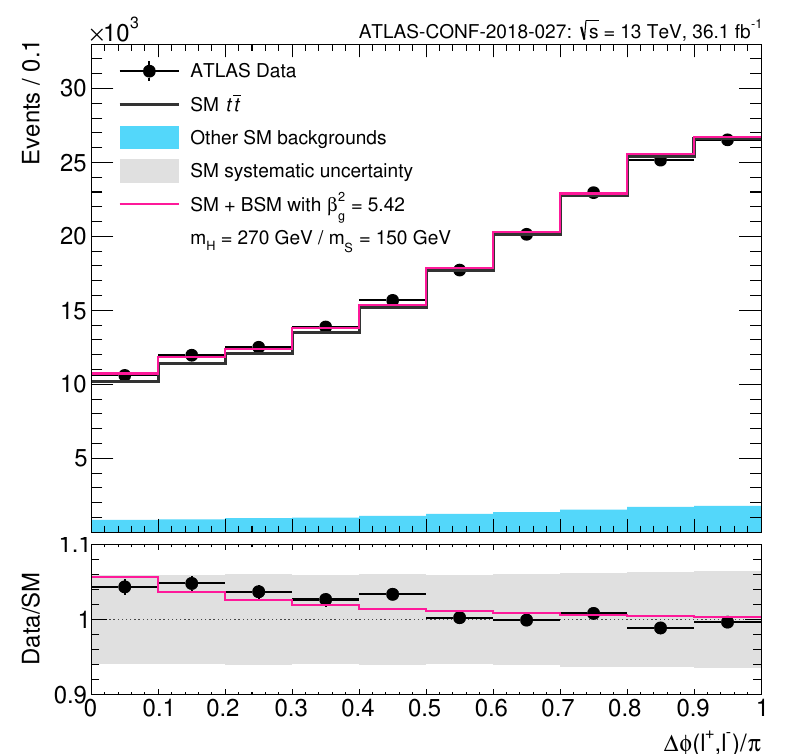
Figure 6 . The SM+BSM (cid:12)t result for the DFOS (cid:1) (cid:30) ( ‘ + ; ‘ (cid:0) ) distribution reported by ATLAS using a partial Run 2 data set. Here, (cid:12) 2 has been scaled to its best-(cid:12)t value. The SM predictions g and systematic uncertainties do not incorporate the constraints imposed by the